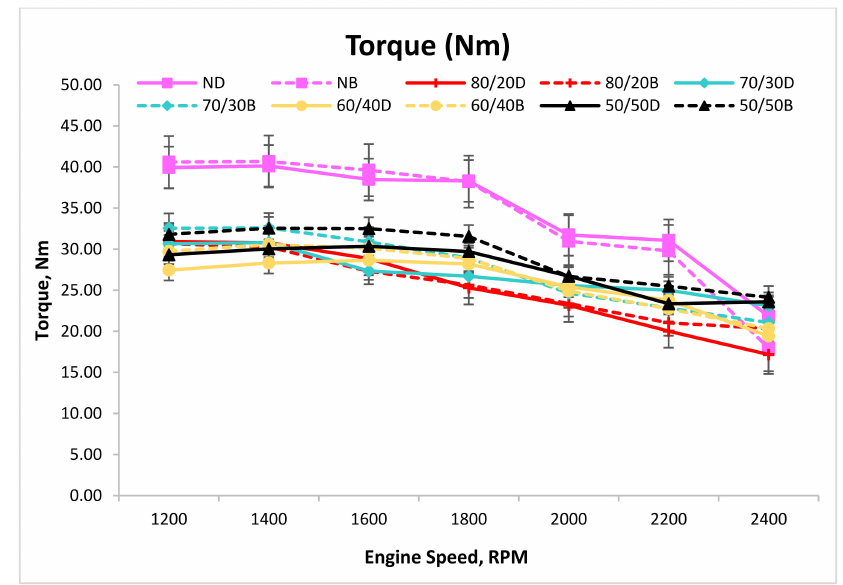
Figure 10. Engine torque at various engine